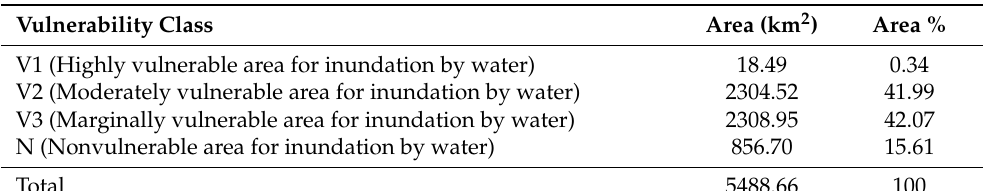
Table 5. Areas vulnerable to inundation according to their vulnerability classes in the Sirajganj and Tangail districts.